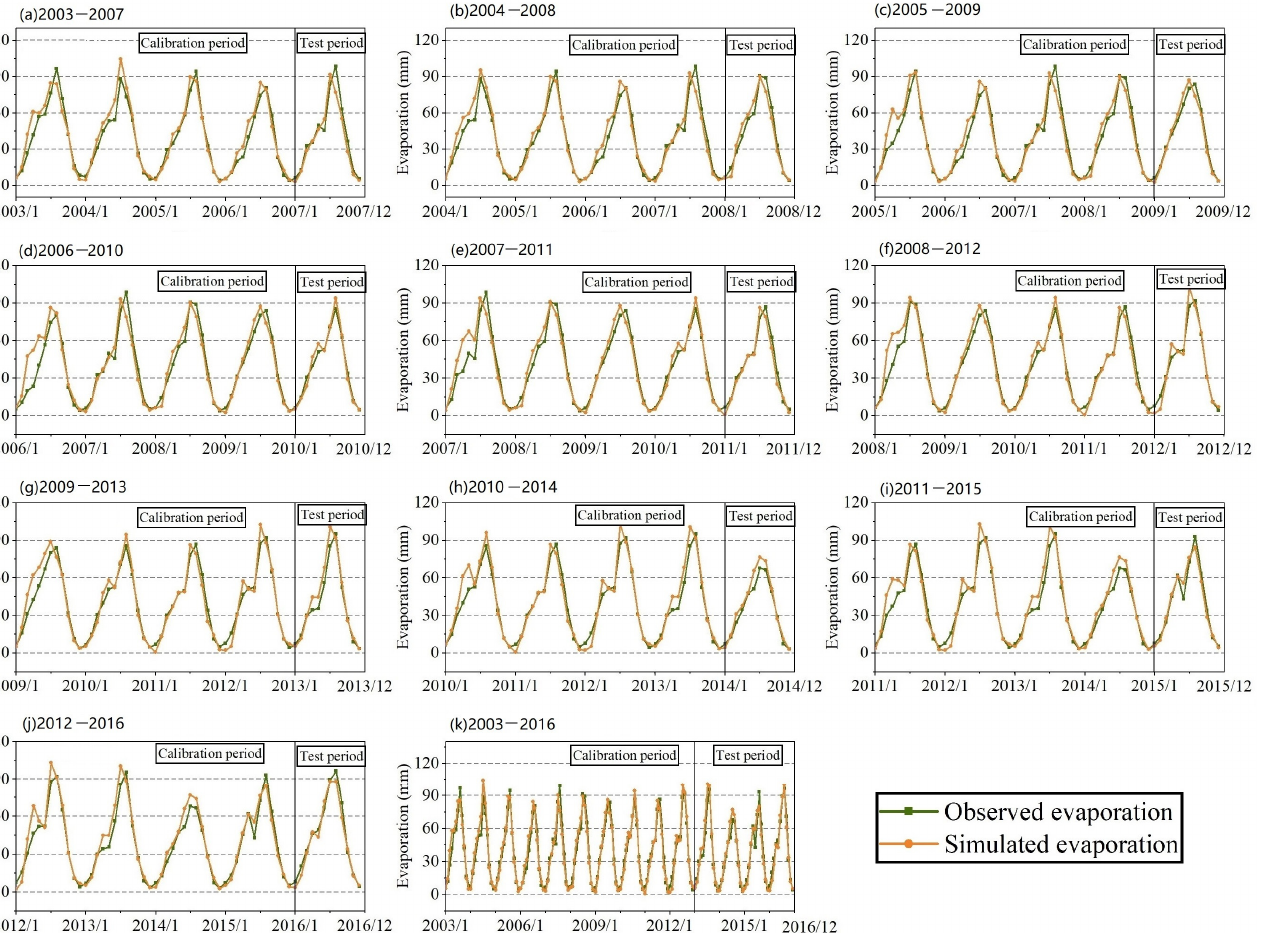
Figure 5. Evaporation simulation by the VIC model both in the whole period ( k ) and the ten sliding window periods ( a – j ).